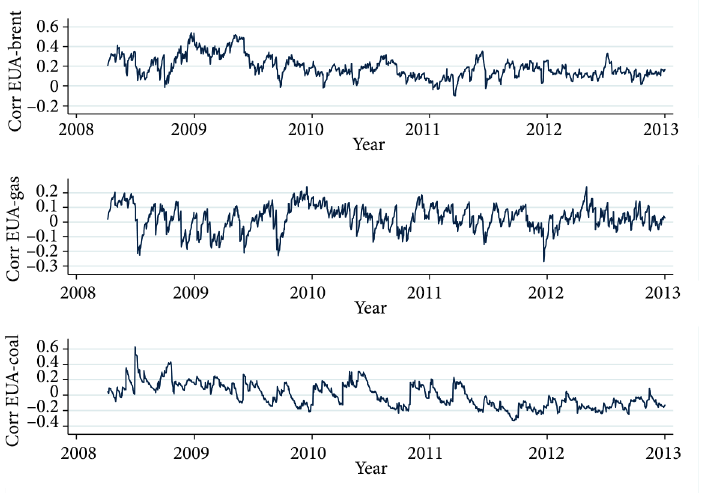
Figure 6. Dynamic correlation between the daily log returns of EUA and the energy futures from the phase II of EU ETS One possible explanation for such a result is that after the 2008 economic crisis the total real emission fell, hence a demand for the allowances. The reduction triggered by economic slowdown was far more than the annual reduction of the cap, which is 6.5% less compared to the 2005 emission level. This led to a large and growing surplus of unused allowances throughout the whole period and prices of the EUA dipped. Such influence exceeded the in- fluence brought by the energy markets, which might be the major reason why the correlation between the EUA and all energy prices decreased during the second period of the EU